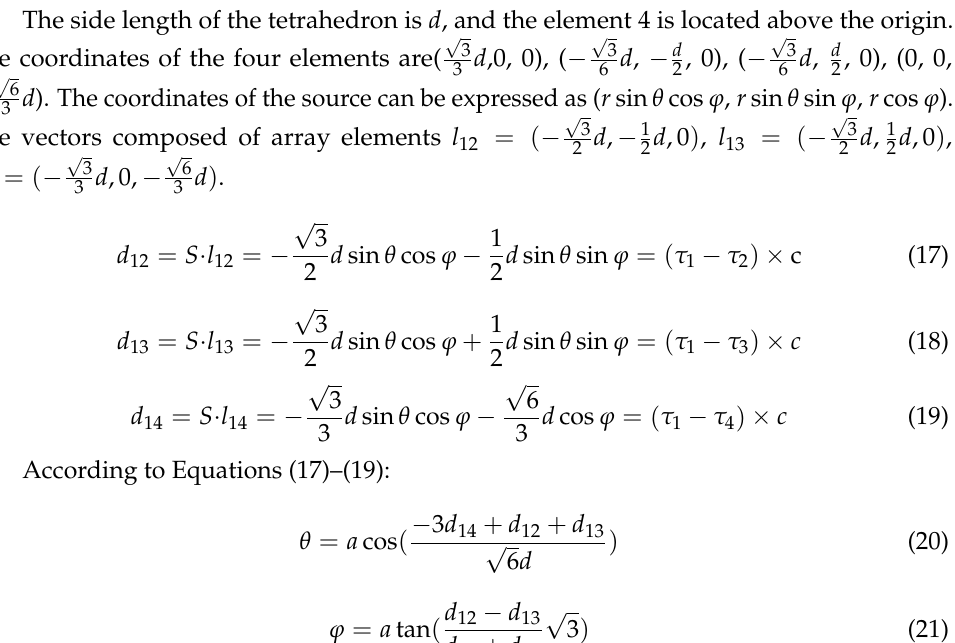
According to Equations (17)–(19):